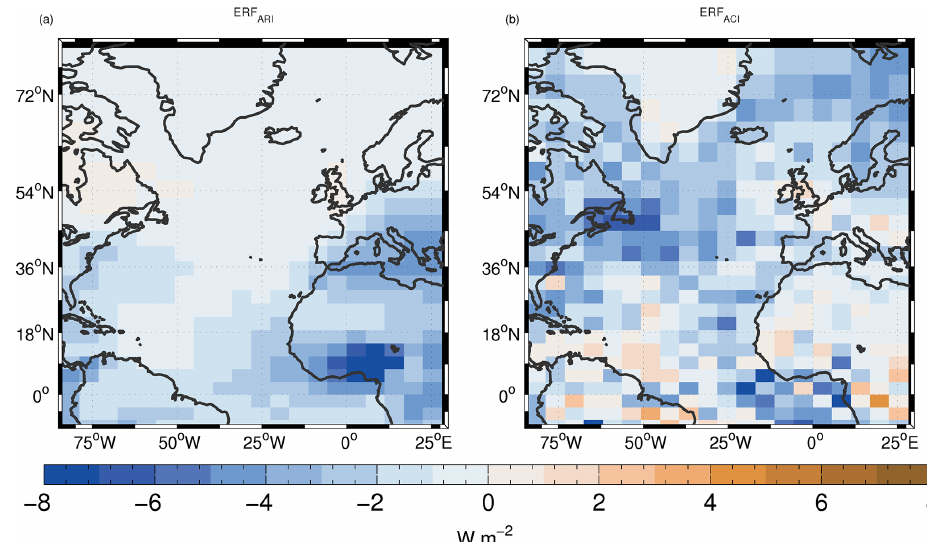
Figure 12. Time-mean ERF ARI (a) and ERF ACI (b) forcing. The maps have been averaged over 3 × 3 grid boxes to help reduce noise.